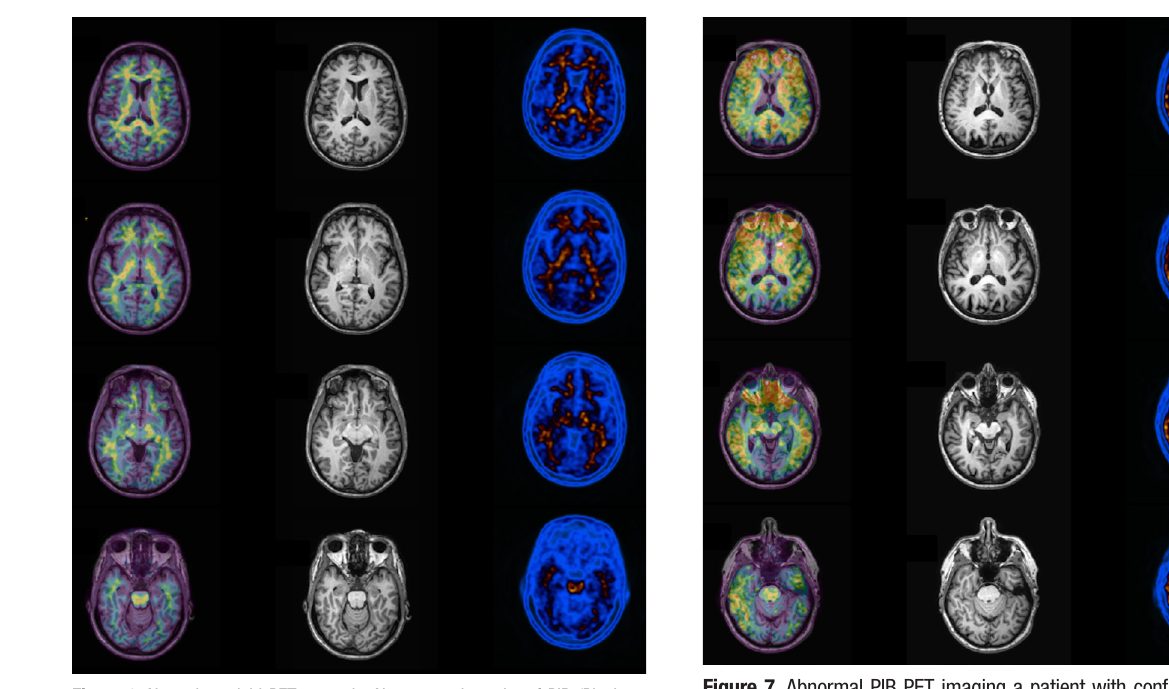
Figure 6. Normal amyloid PET example. Note normal uptake of PIB (Pittsburg Compound) labeled with carbon-11 in white matter tissue at the left column. In the middle column it is shown the MR images of the patient, and in the right column the fused images (PIB + MRI). No cortical uptake of 11C-PIB is seen in this case.